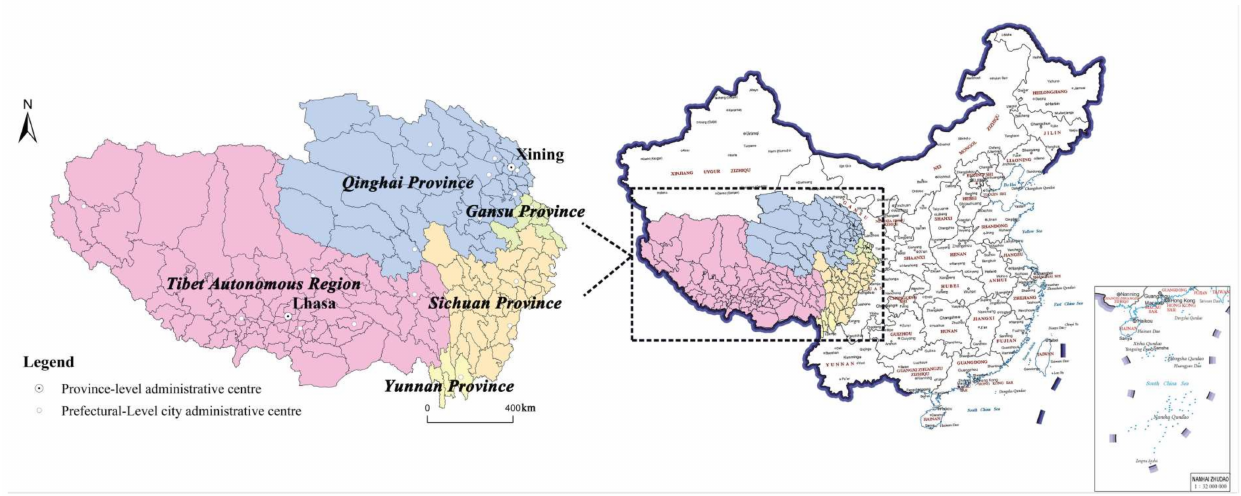
Figure 1. The location of study area (Map Approval Number: GS